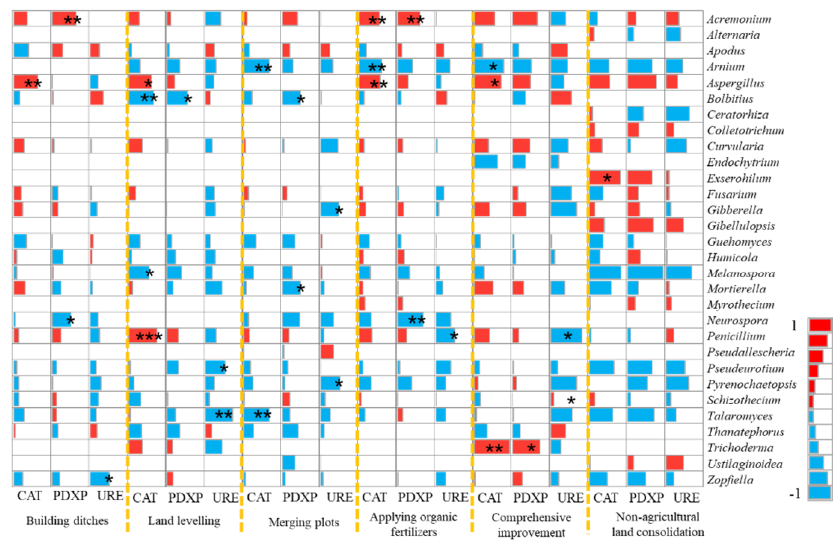
Figure 11. Correlation between soil enzyme activity and fungal community structure in different groups. (Note: In the figure, warm colors indicate positive correlation, and cool colors indicate neg- ative correlation. *, **, *** indicate significant correlation at the levels of 0.05, 0.01, and 0.001, respec- tively).